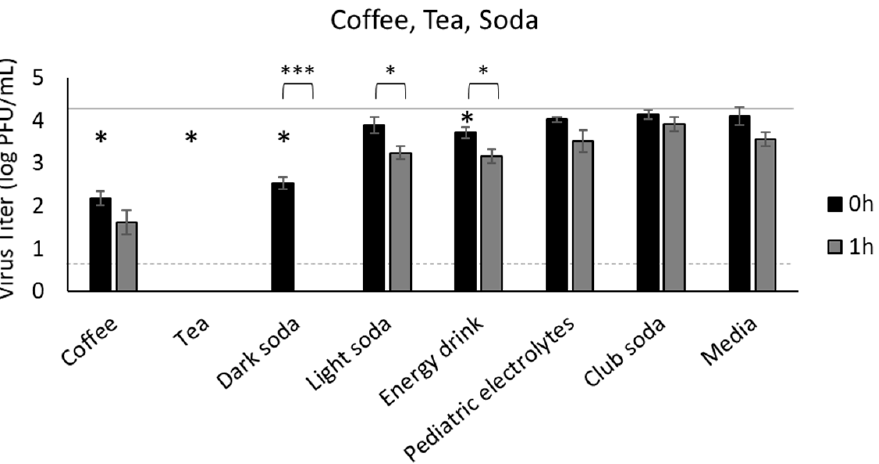
Figure 2. Survival of SARS-CoV-2 in coffee, tea, soda, energy drink, and pediatric electrolyte beverage. SARS-CoV-2 was recovered from beverages immediately after inoculation (0 h) and 1 h later, quantified by plaque assay on Vero E6 cells and shown as log PFU/mL. Infectious virus was significantly reduced at 0 h in coffee, tea, dark soda ( p < 0.0001), and energy drink ( p < 0.0177). The inoculum is shown as a solid gray line (4.3 log PFU/mL) and the detection limit of the plaque assay is shown as a dashed line (0.7 log PFU/mL). Significant differences between 0 h and inoculum are shown with an asterisk. Significant differences between means at 0 h and 1 h are shown by brackets and asterisks (* <0.05; *** <0.001). Error bars = SEM.